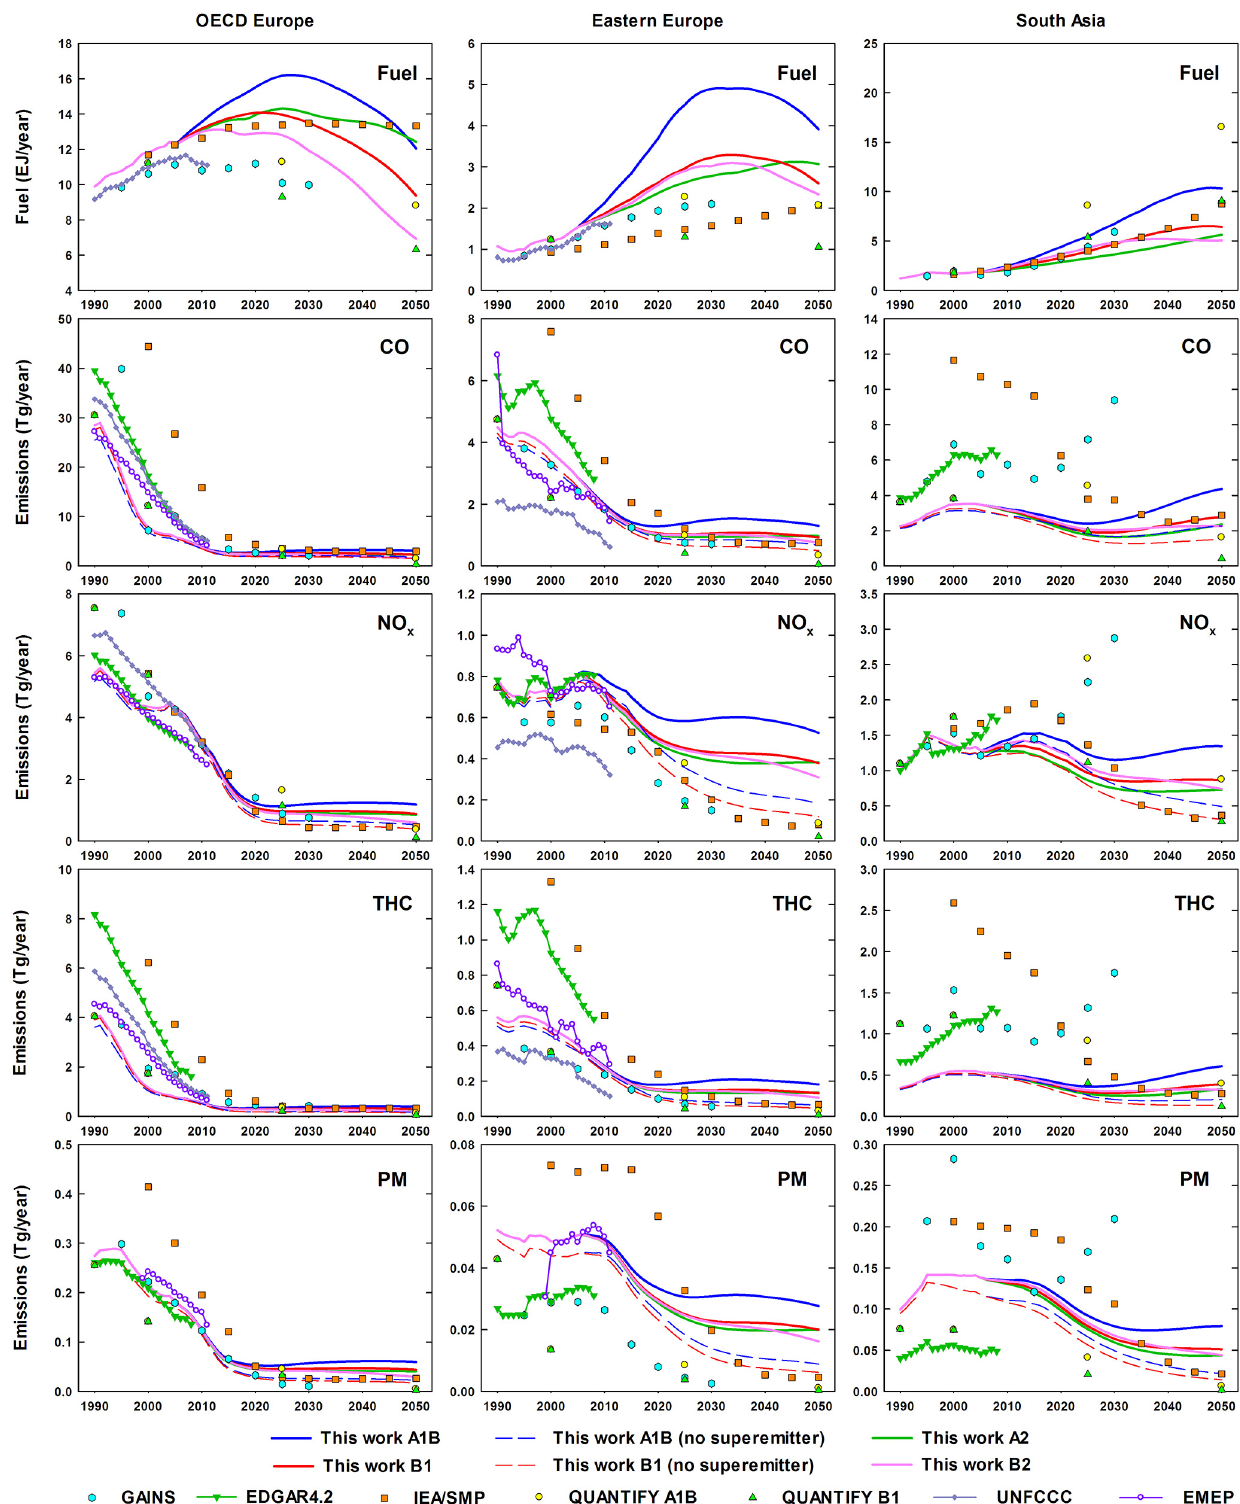
Figure 4. Comparison of regional (OECD Europe, left; Eastern Europe, middle; South Asia, right) fuel and emission estimates for on-road vehicles in this work with previous studies: GAINS (scenario: BL_WEO_2010) (Klimont et al., 2009), EDGAR (version 4.2) (JRC/PBL, 2011), IEA/SMP (Fulton and Eads, 2004), QUANTIFY (DLR, 2009), UNFCCC (UNFCCC, 2006), and EMEP (EMEP,